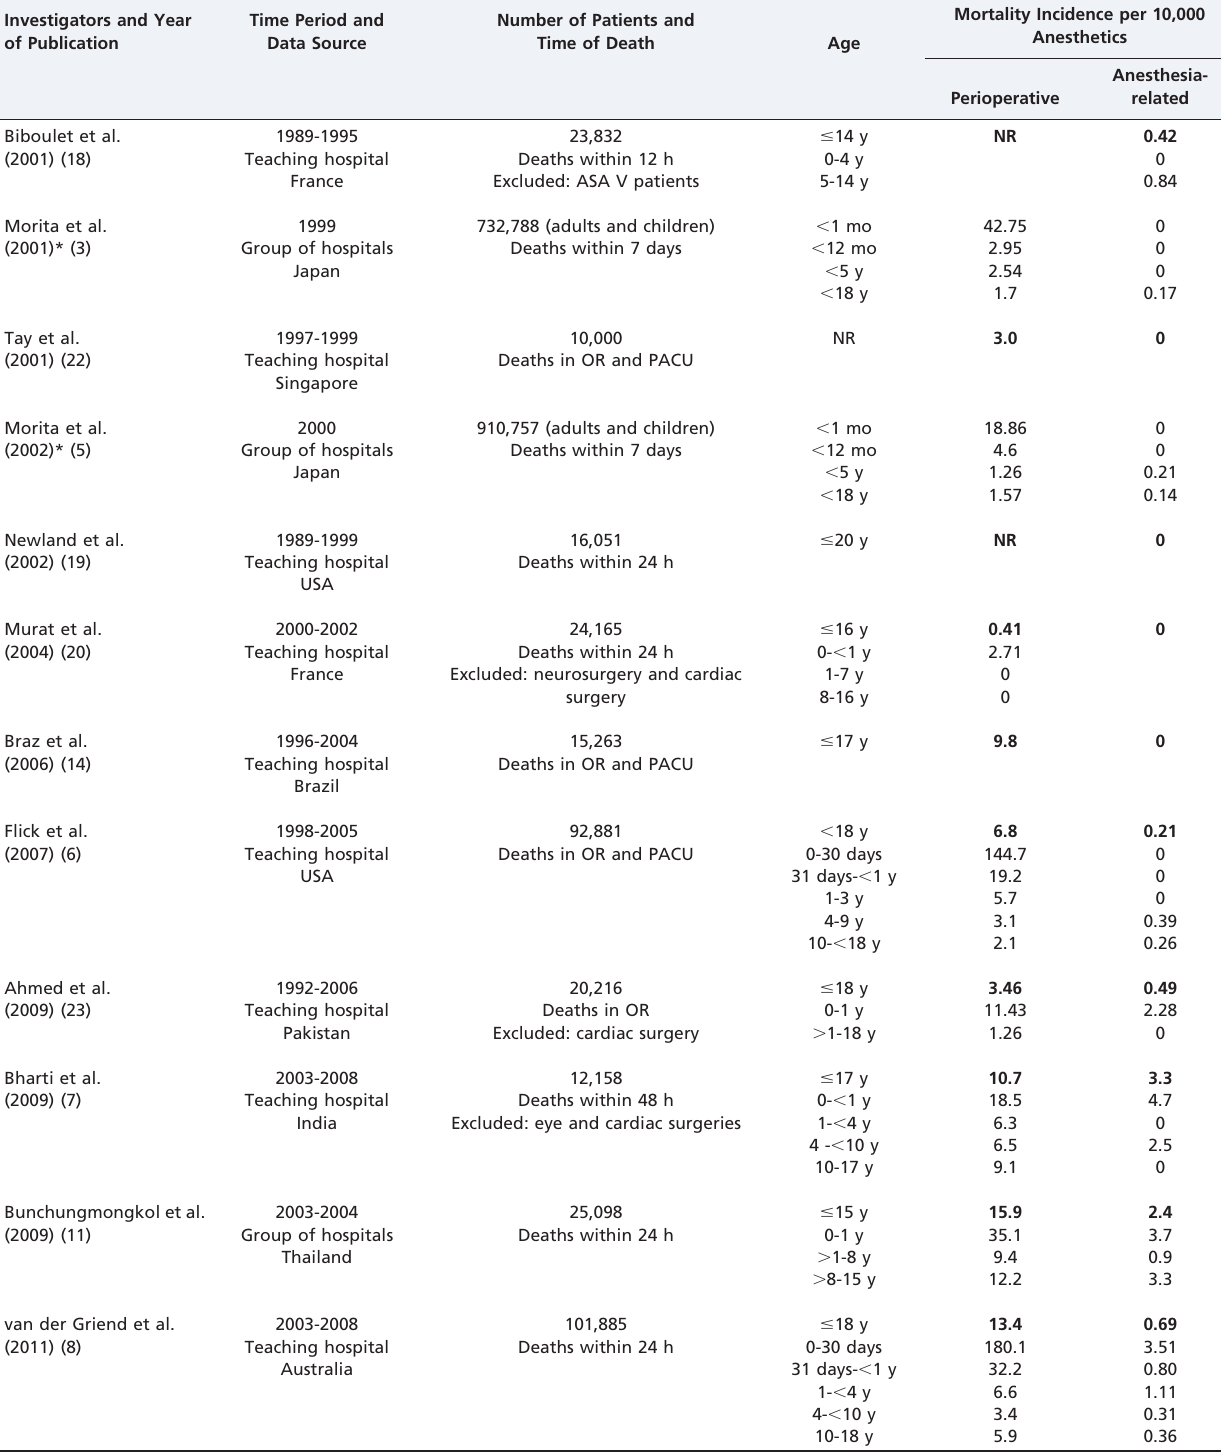
Mortality Incidence per 10,000